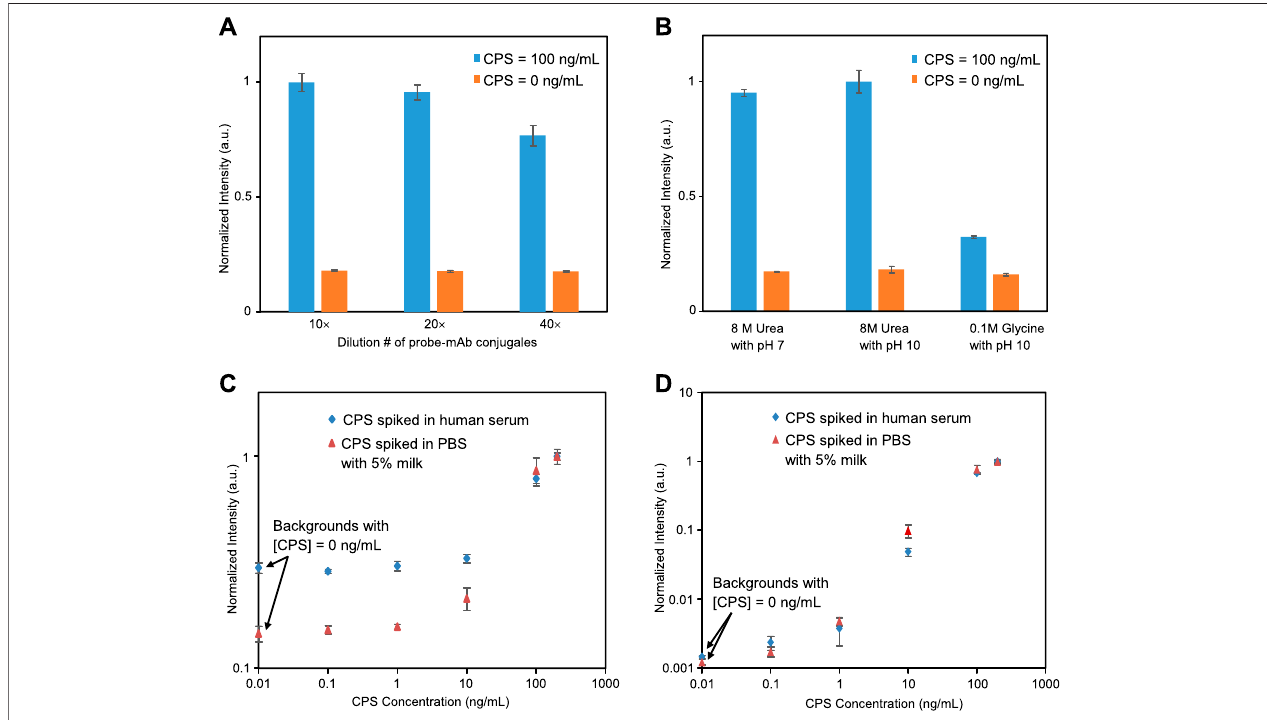
FIGURE 3 | (A) Dilution optimization of antibody-coated NC probes for immunoassay. (B) Optimal selection of immunoaf fi nity separation solutions for immunoassay (all separation solutions contain 0.1% BSA and 1% SDS, and the optimization experiments were done with measurements using a standard non-time- gated microplate reader). (C) Calibration curves of immunoassays measured using a standard nongated microplate reader. (D) Calibration curves of immunoassays measured using the time-gated